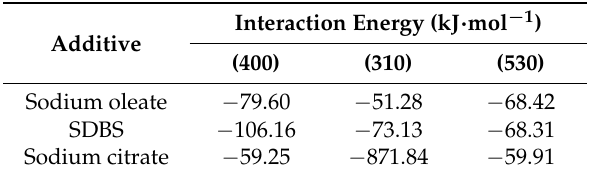
Table 2. Interaction energy of additives on predominant crystal